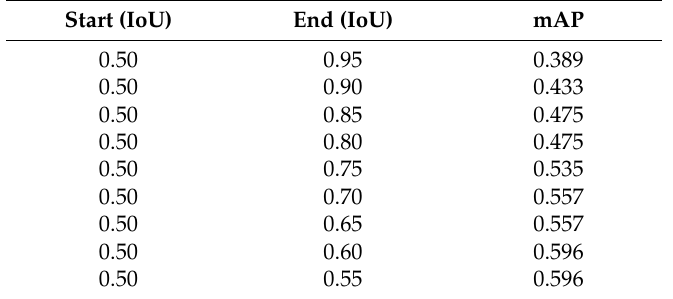
Table 3. mAP results for validation data using di ff erent intersection of union (IoU) ranges. Start